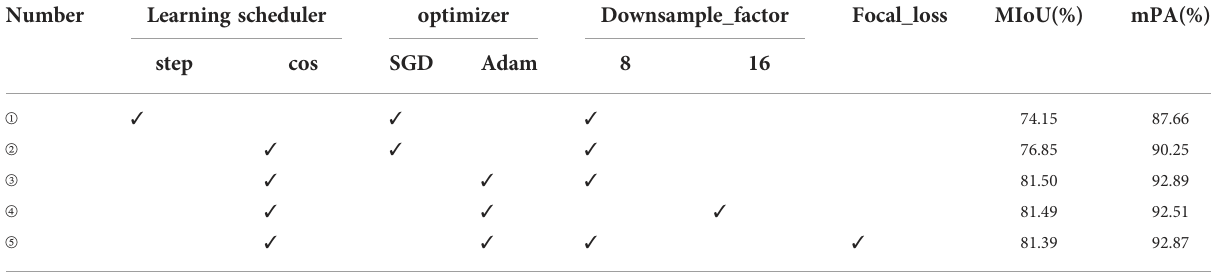
TABLE 3 Network segmentation performance comparison for different parameters